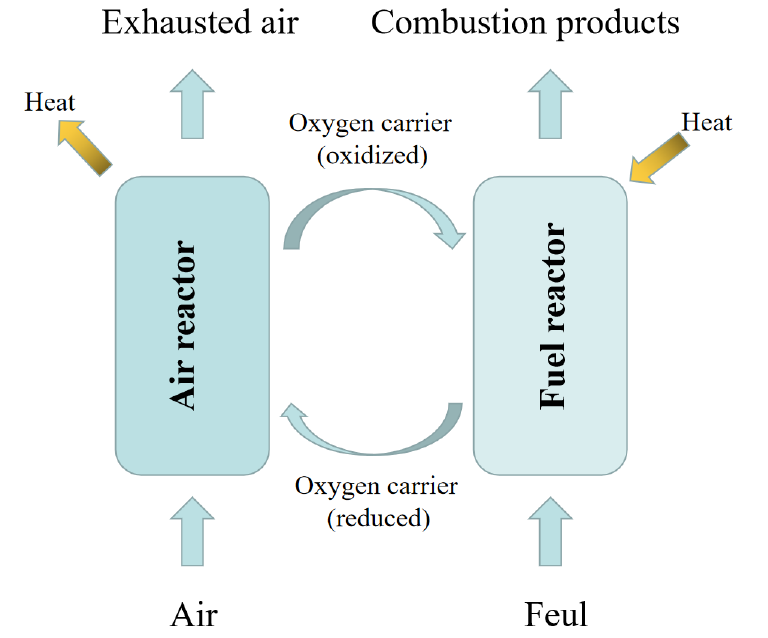
Figure 1. Schematic of chemical looping combustion